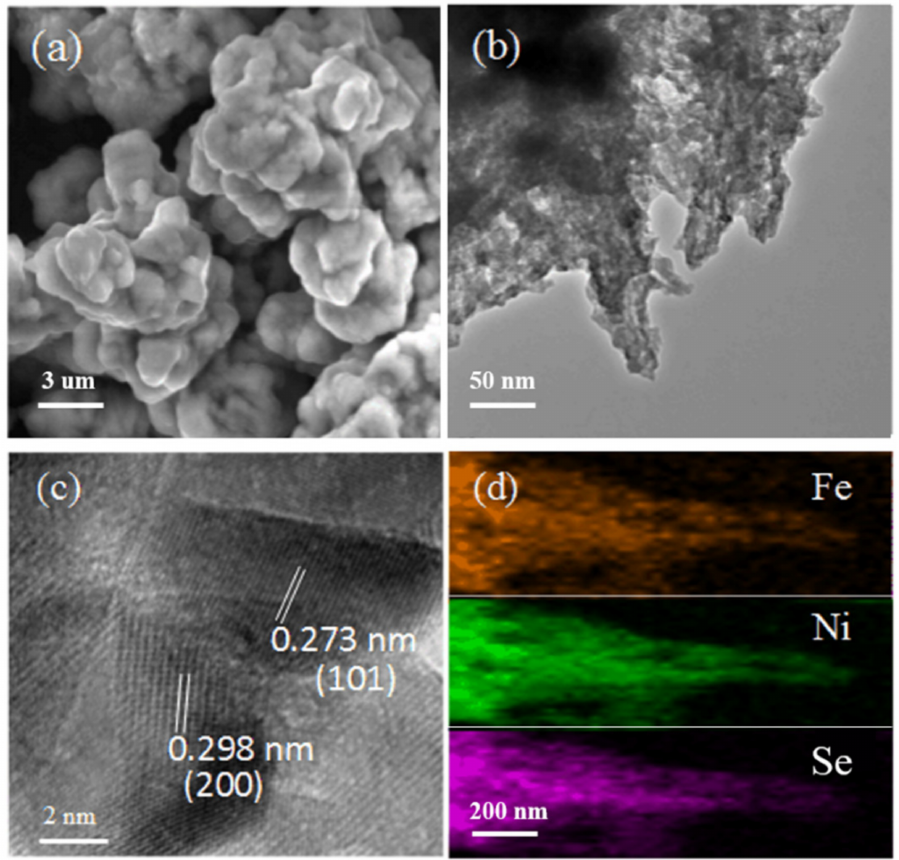
Figure 7. SEM and TEM characterization maps of Fe 0.2 Ni 0.8 Se. ( a ) Fe 0.2 Ni 0.8 Se—low magnification SEM; ( b ) Fe 0.2 Ni 0.8 Se—low magnification TEM; ( c ) Fe 0.2 Ni 0.8 Se—high magnification TEM; ( d ) EDS mapping of Fe, Ni,